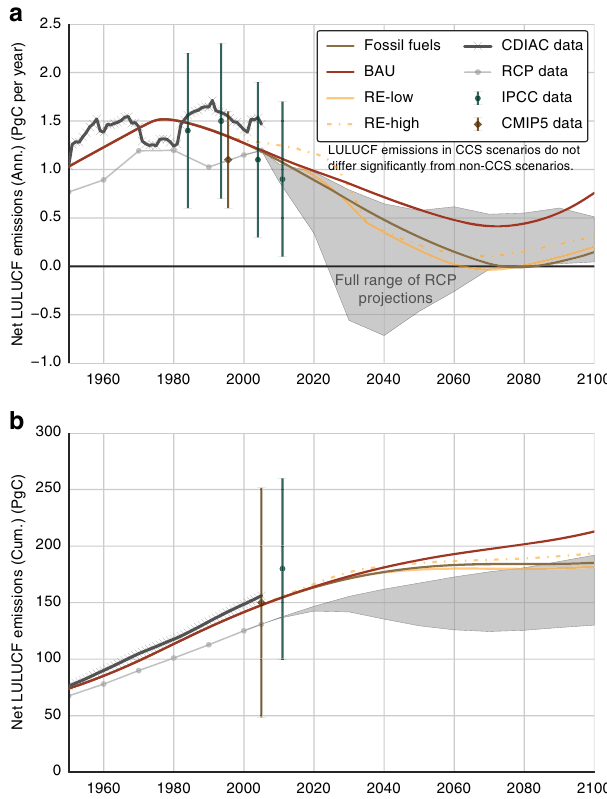
Figure 4 | LULUCF sector carbon emissions. ( a ) Annual net emissions (PgC per year); ( b ) cumulative net emissions (PgC). Sources of historical data and errors ( cf. equation 12): IPCC AR5 (green bars) 3 , CMIP5 (brown bars) 5 , CDIAC (thick grey lines) 33 and RCP database (thin grey lines) 7 . For comparison, RCP projections through 2100 are indicated as a single grey